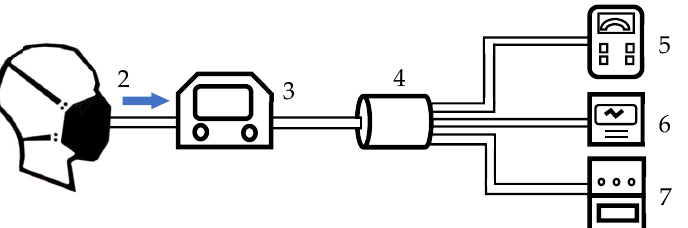
Figure 3. Experimental test scheme, 1—test subject, 2—face mask, 3—particle monitor, 4—air mixing tube, 5—O 2 concentration monitor, 6—temperature, and relative humidity meter, 7—CO 2 concentra- tion